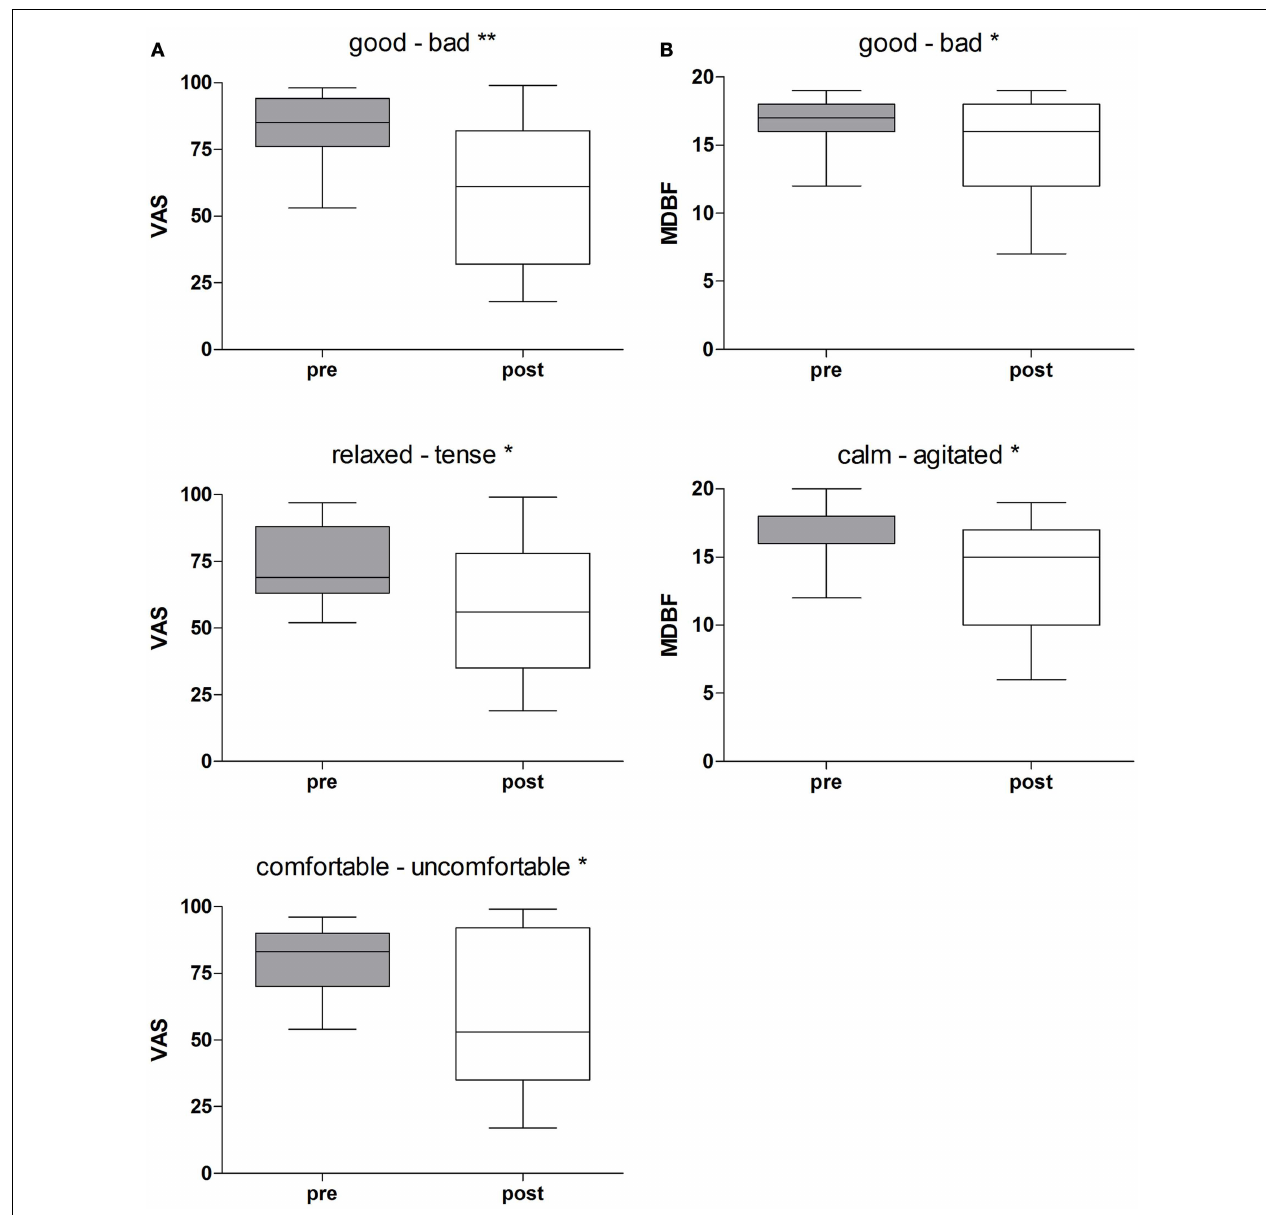
** p < 0.01. (B) Rotational stimulation and impact on mood states using MDBF-scales. Boxplots of significant effects of the rotational stimulation on mood states using MDBF-scales in a pre-post comparison. Box plots showing the median, upper, and lower quartile, with whiskers showing the minimum and maximum of all values. High values indicated that the positive adjective of the pair was appropriate and vice versa for low values. * p < 0.05.